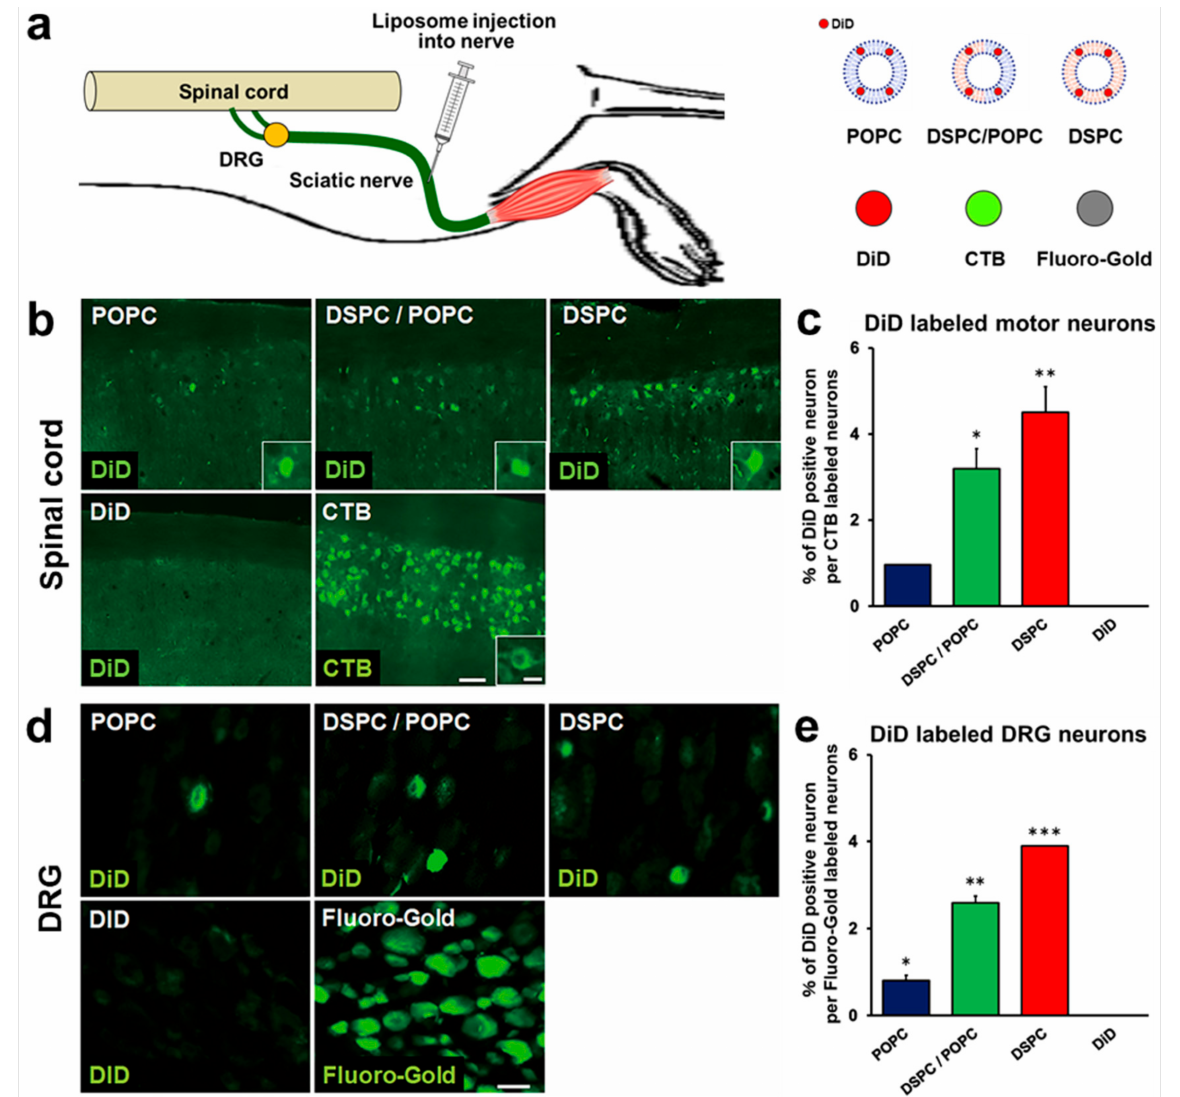
Figure 2. Retrograde transport of liposomes consisting of different phospholipids to spinal cord motor neurons and DRG neurons 3 days after sciatic nerve injection. ( a ) Schematic overview of sciatic nerve injection. ( b ) Horizontal sections of the lumbar spinal cord. Rostral is left. Liposomes were composed of POPC alone, DSPC alone, or both POPC and DSPC. Motor neurons receiving retrogradely transported liposomes were identified by fluorescence of conjugated DiD. Insets are high-magnification views of DiD-labeled motor neurons. DiD alone was not transported to motor neurons in 3 days, whereas many motor neurons were labeled by CTB. Scale bars, 100 µ m, 30 µ m (inset). ( c ) The efficiency of retrograde transport of liposomes. The percentage of DiD-labeled motor neurons of the total number of CTB-labeled motor neurons ( n = 3/group). DSPC liposomes had the highest transport efficiency among the four groups. Data are the mean ± standard deviation (SD). * p < 0.05, ** p < 0.05 vs. all other groups by one-way ANOVA with the Tukey–Kramer test. ( d ) L5 DRG sections. DRG neurons receiving retrogradely transported liposomes were identified by DiD fluorescence. DiD alone was not transported to DRG neurons, whereas most neurons were labeled with Fluoro-Gold. Scale bar, 40 µ m. ( e ) The percentage of DiD-labeledDRG neurons of the total number of Fluoro-Gold-labeled neurons was quantified ( n = 3/group). Data are the mean ± SD. * p < 0.05, ** p < 0.05, *** p < 0.05 vs. all other groups by one-way ANOVA with the Tukey–Kramer